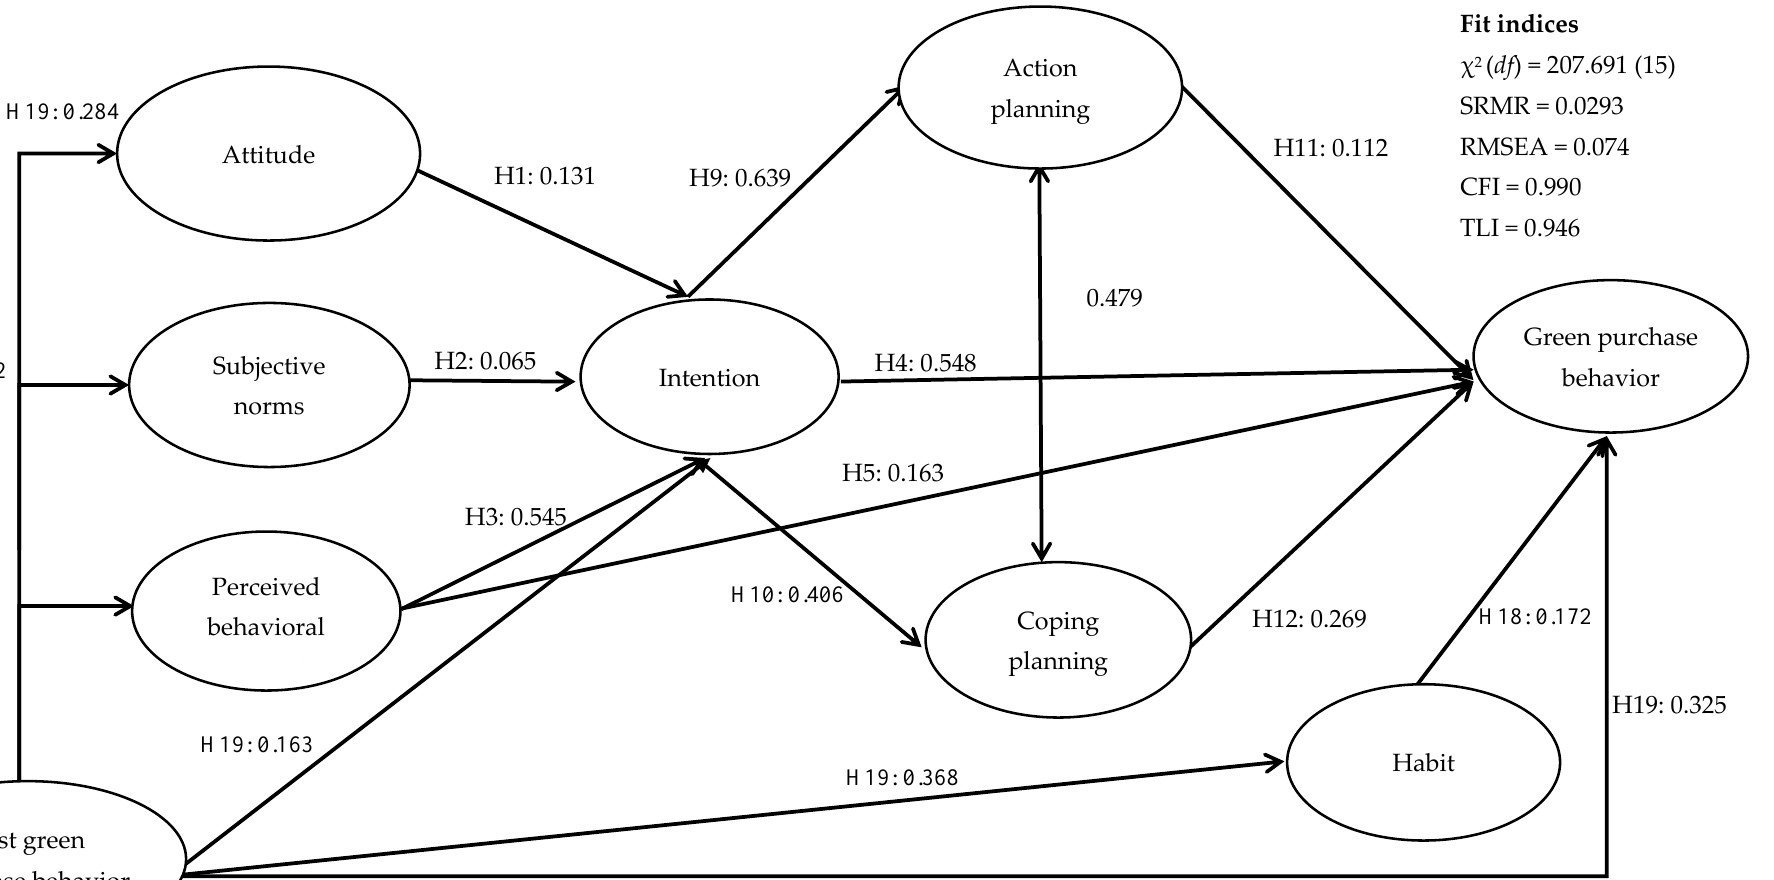
Figure 1. Standardized path coefficients for structural equation model of relations among integrated social cognition model. Note . The following covariates were set to predict all model variables; omitted from the diagram for clarity are age, gender, and father’s education. All hypothesized effects were proposed to be positive in direction.